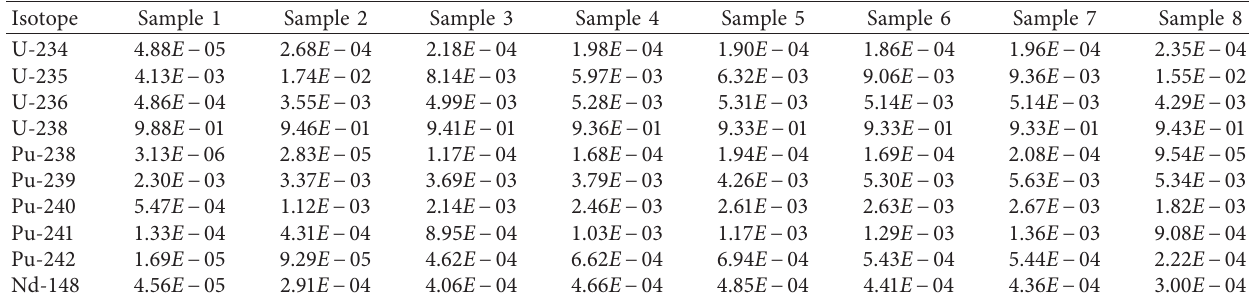
Table 3: Experimental data used for validation for the 2F2DN23/SF98 benchmark.